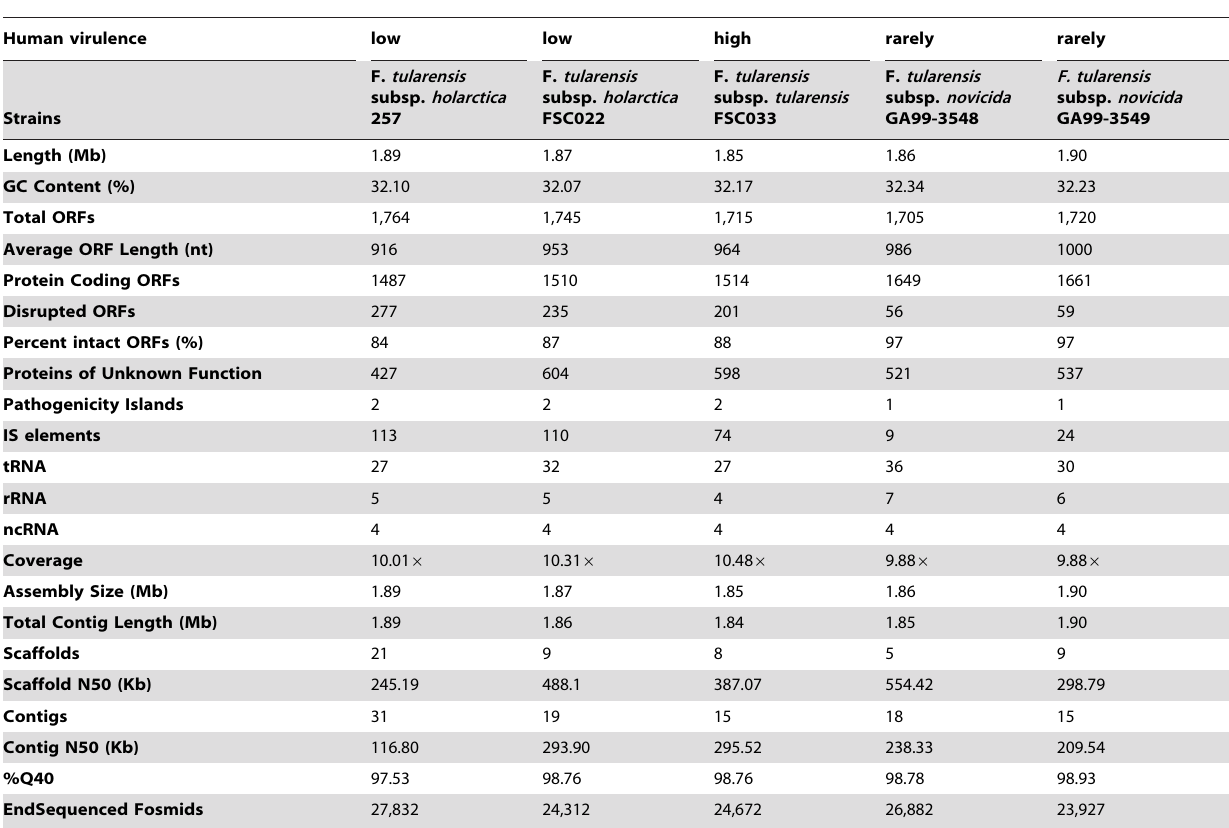
Table 1. Gene and Assembly Statistics Summary.